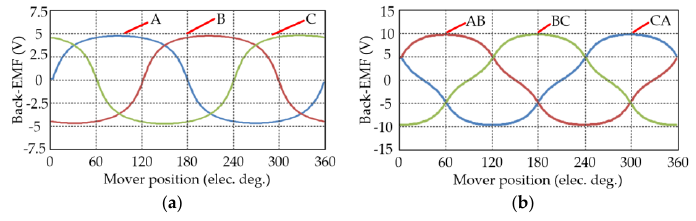
Figure 9. No-load back-EMF: ( a ) The three-phase; ( b ) The line.